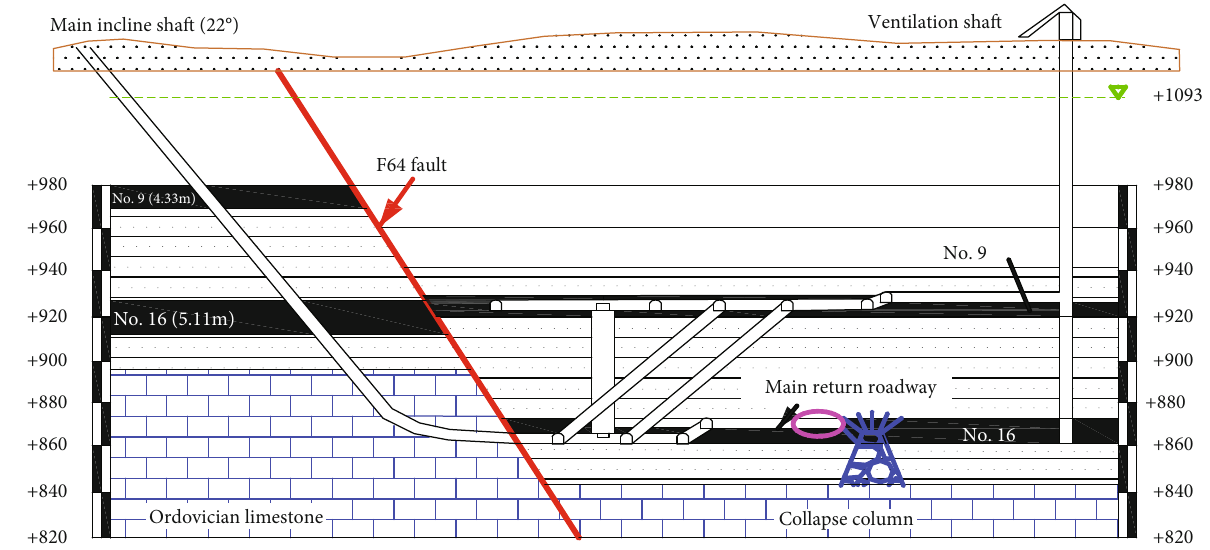
Figure 1: Location of the water inrush accident in the Luotuoshan coal